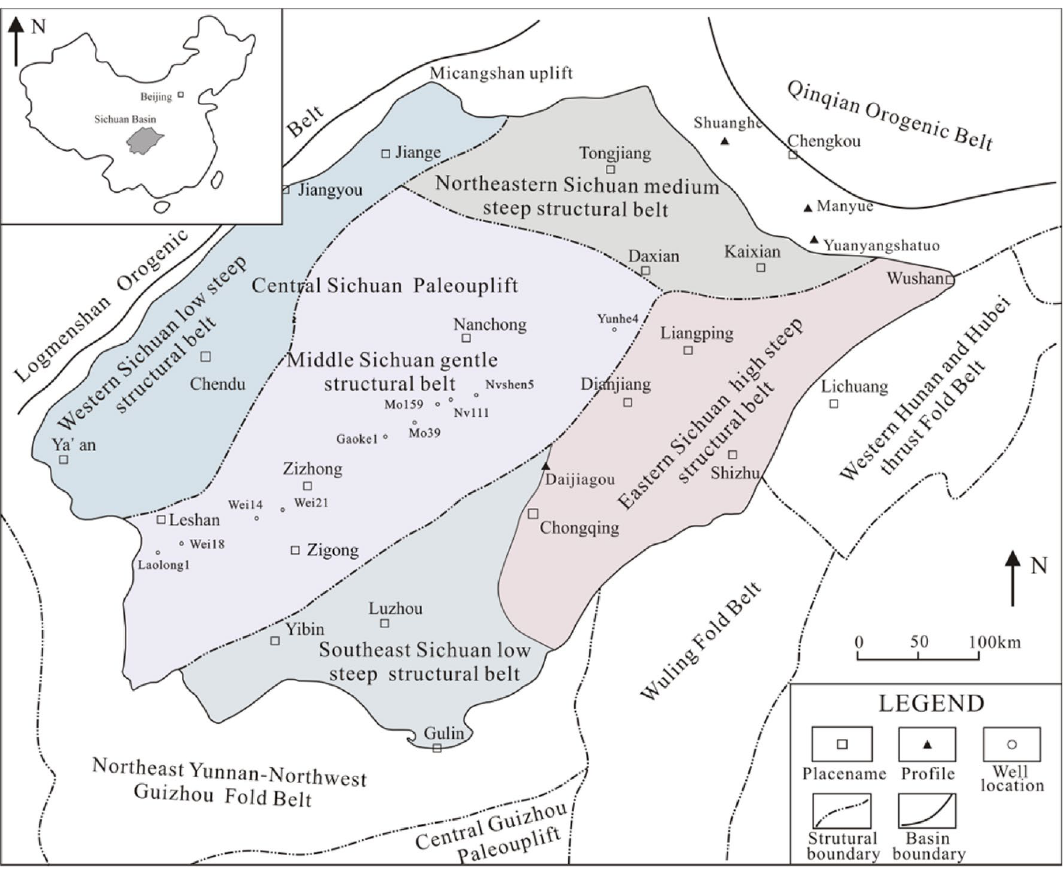
Fig. 1 Simplified structural subdivisions of the Sichuan